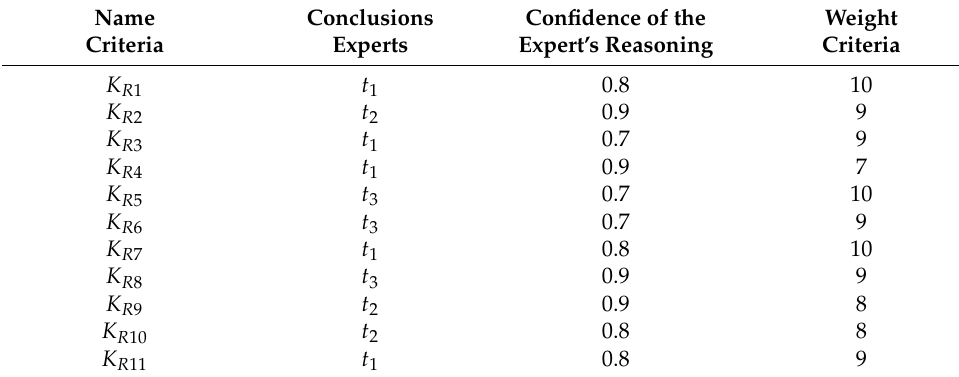
Table 2. Input data on expert evaluation according to K R .